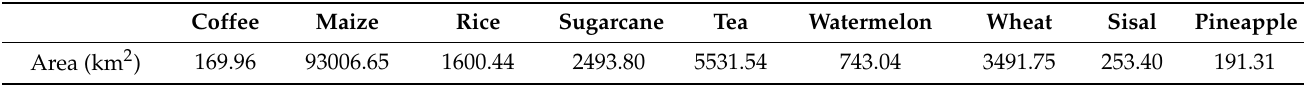
Table 4. Area distribution of major crops in Kenya in 2020 obtained using RF classifier (unit: km 2 ). Coffee Maize Rice